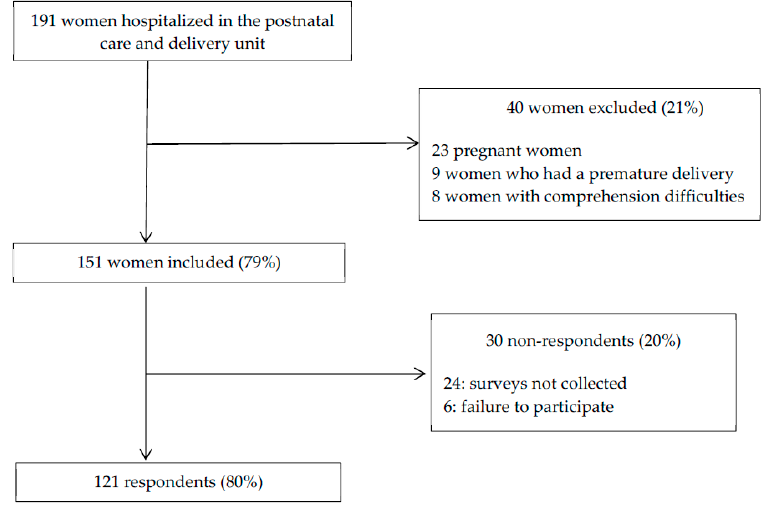
Figure 1. Inclusion and participation rate of women hospitalized in the postnatal care and delivery unit at the time of the study.